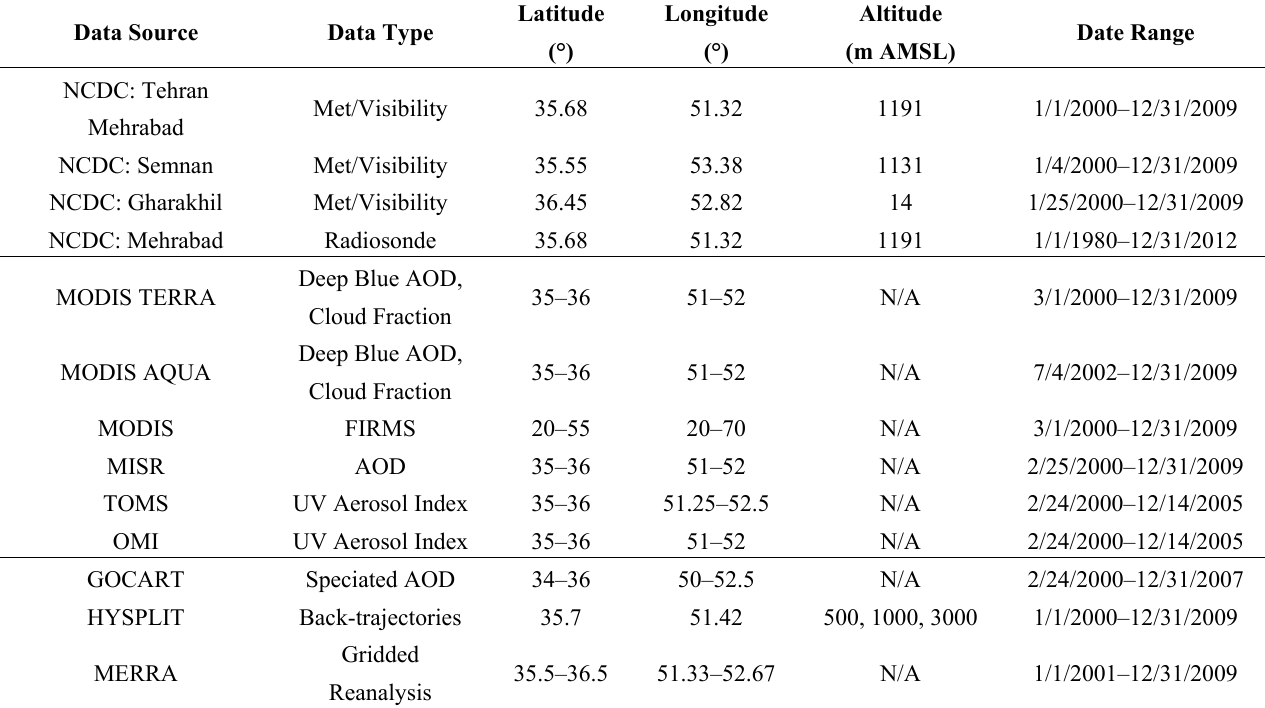
Table 1. Summary of temporal and spatial characteristics of datasets